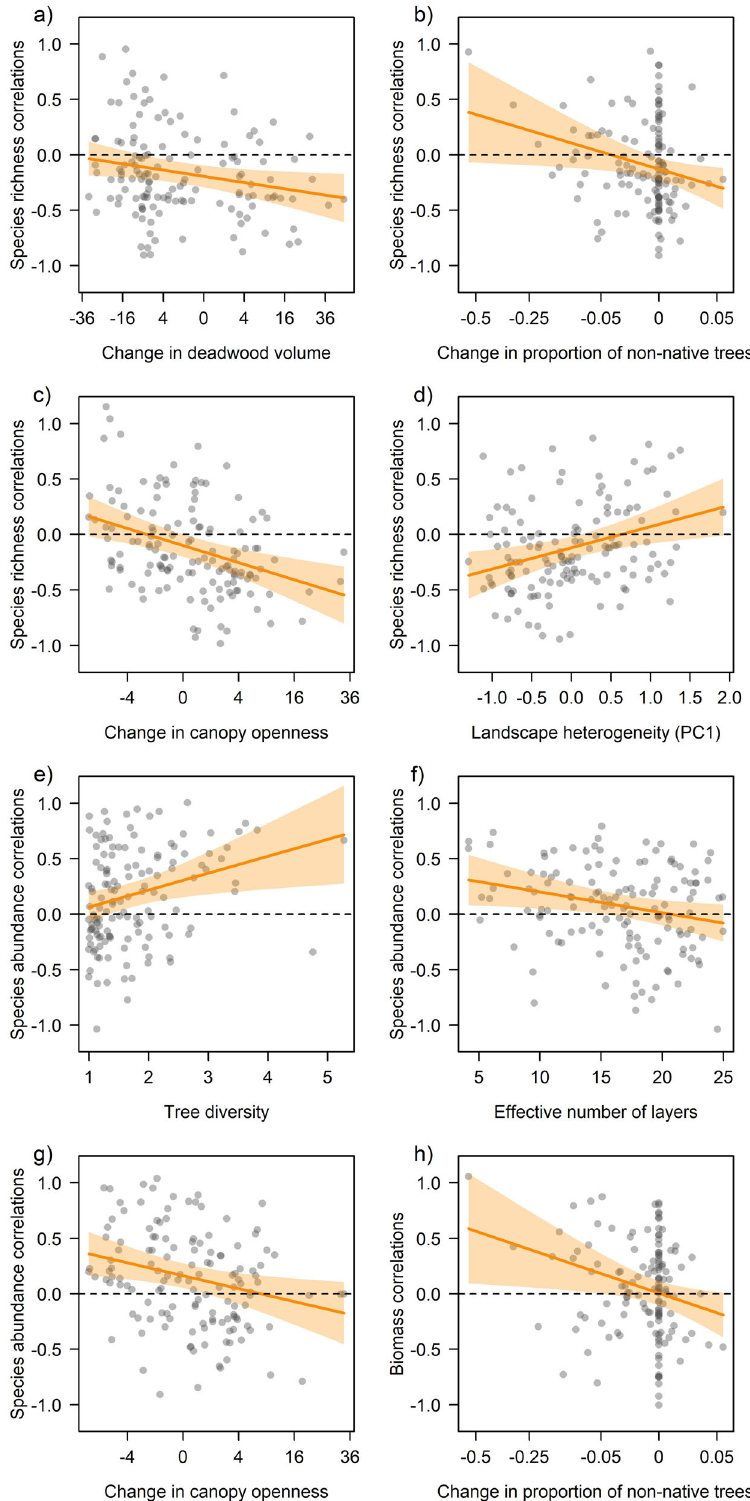
Fig. 3 Results for site-level correlations of the total insect community and further environmental variables. Site-level correlations (each shown as partial residuals of Pearson ’ s r between year and the respective community response) for species richness were related to a change in deadwood volume, b change in the proportion of non-native trees, c change in canopy openness, and d PC1 of landscape heterogeneity. For species abundance, site-level correlations were related to e tree diversity, f the effective number of layers, and g change in canopy openness. Site-level correlations for biomass were related to h the change in the proportion of non-native trees. For explanations of variables see Supplementary Table 1. Full statistical details are available in Supplementary Data 1. Regression lines (95% CI in shaded polygons) indicate the marginal predictions of linear mixed-effects models. Dashed horizontal lines mark null with negative values indicating sites with declining and positive values sites with increasing community responses over time. Note that the x -axes in a , b , c , g and h are on a symmetric square-root